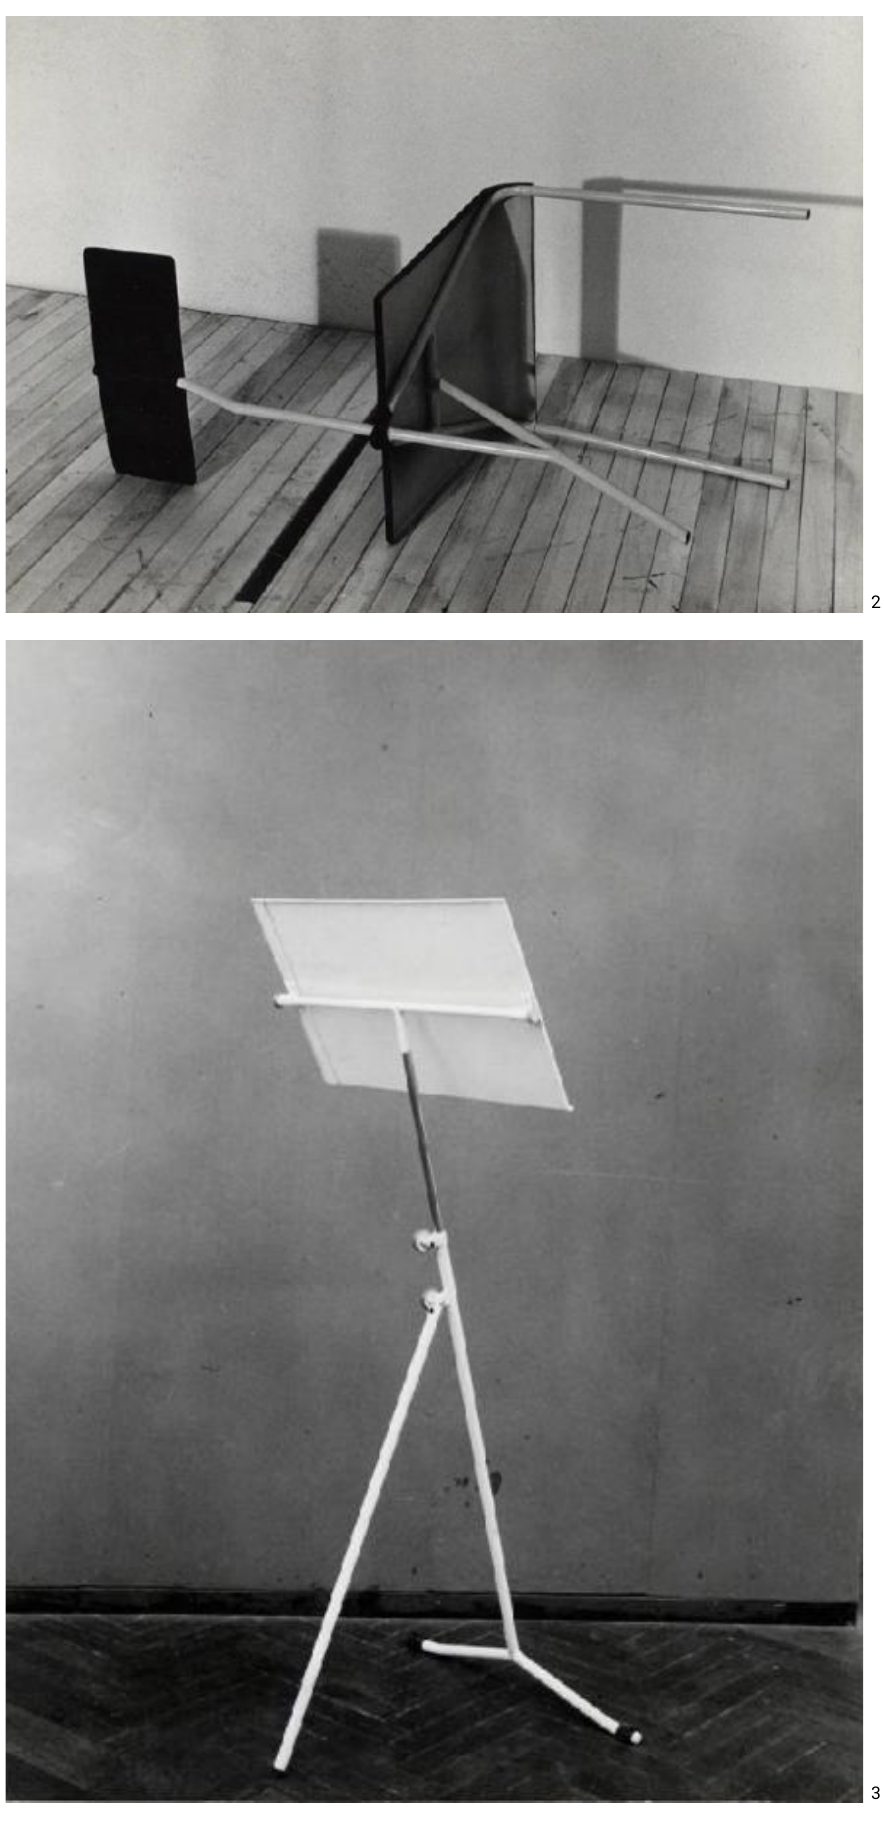
Front view of the lectern designed by Giancarlo De Carlo,exhibited in VIII Triennale furniture section, part two, single furniture composed in groups. (ph. Casali - S.E.M.) source: http://www.lombardiabe- niculturali.it/fotografie/schede/